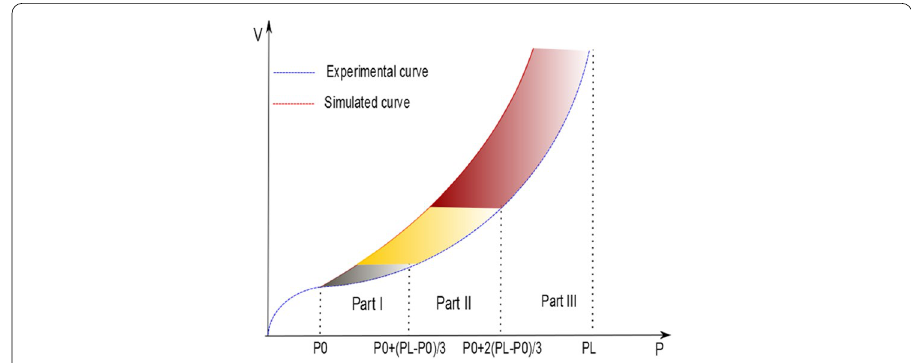
Fig. 9 Subdivision of the pressuremeter curve in the decomposition method